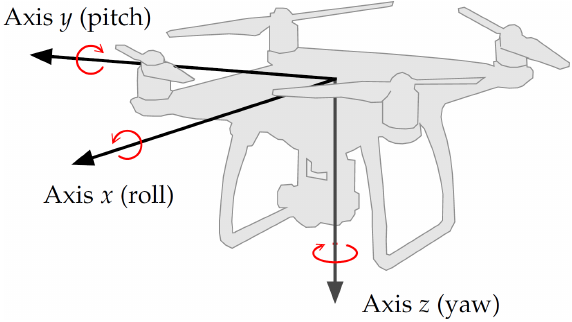
Figure 7. Attitude angles as measured by DJI Phantom 4, adapted from